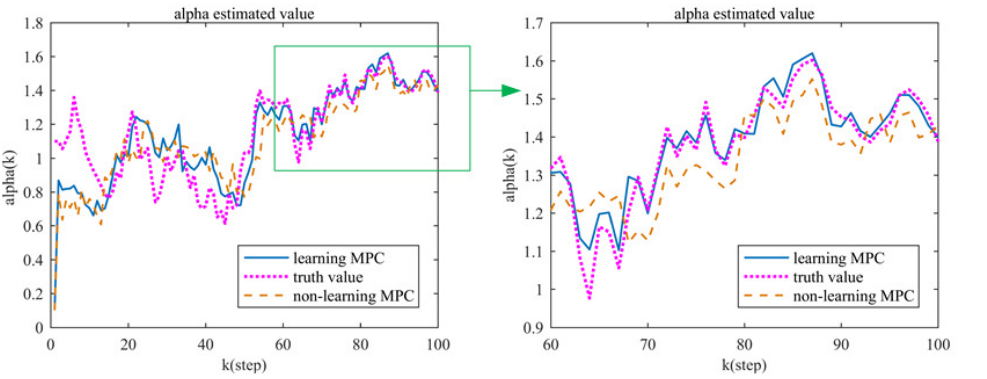
Figure 5. Estimated and true α ( k ) values when the parameter varies with time.